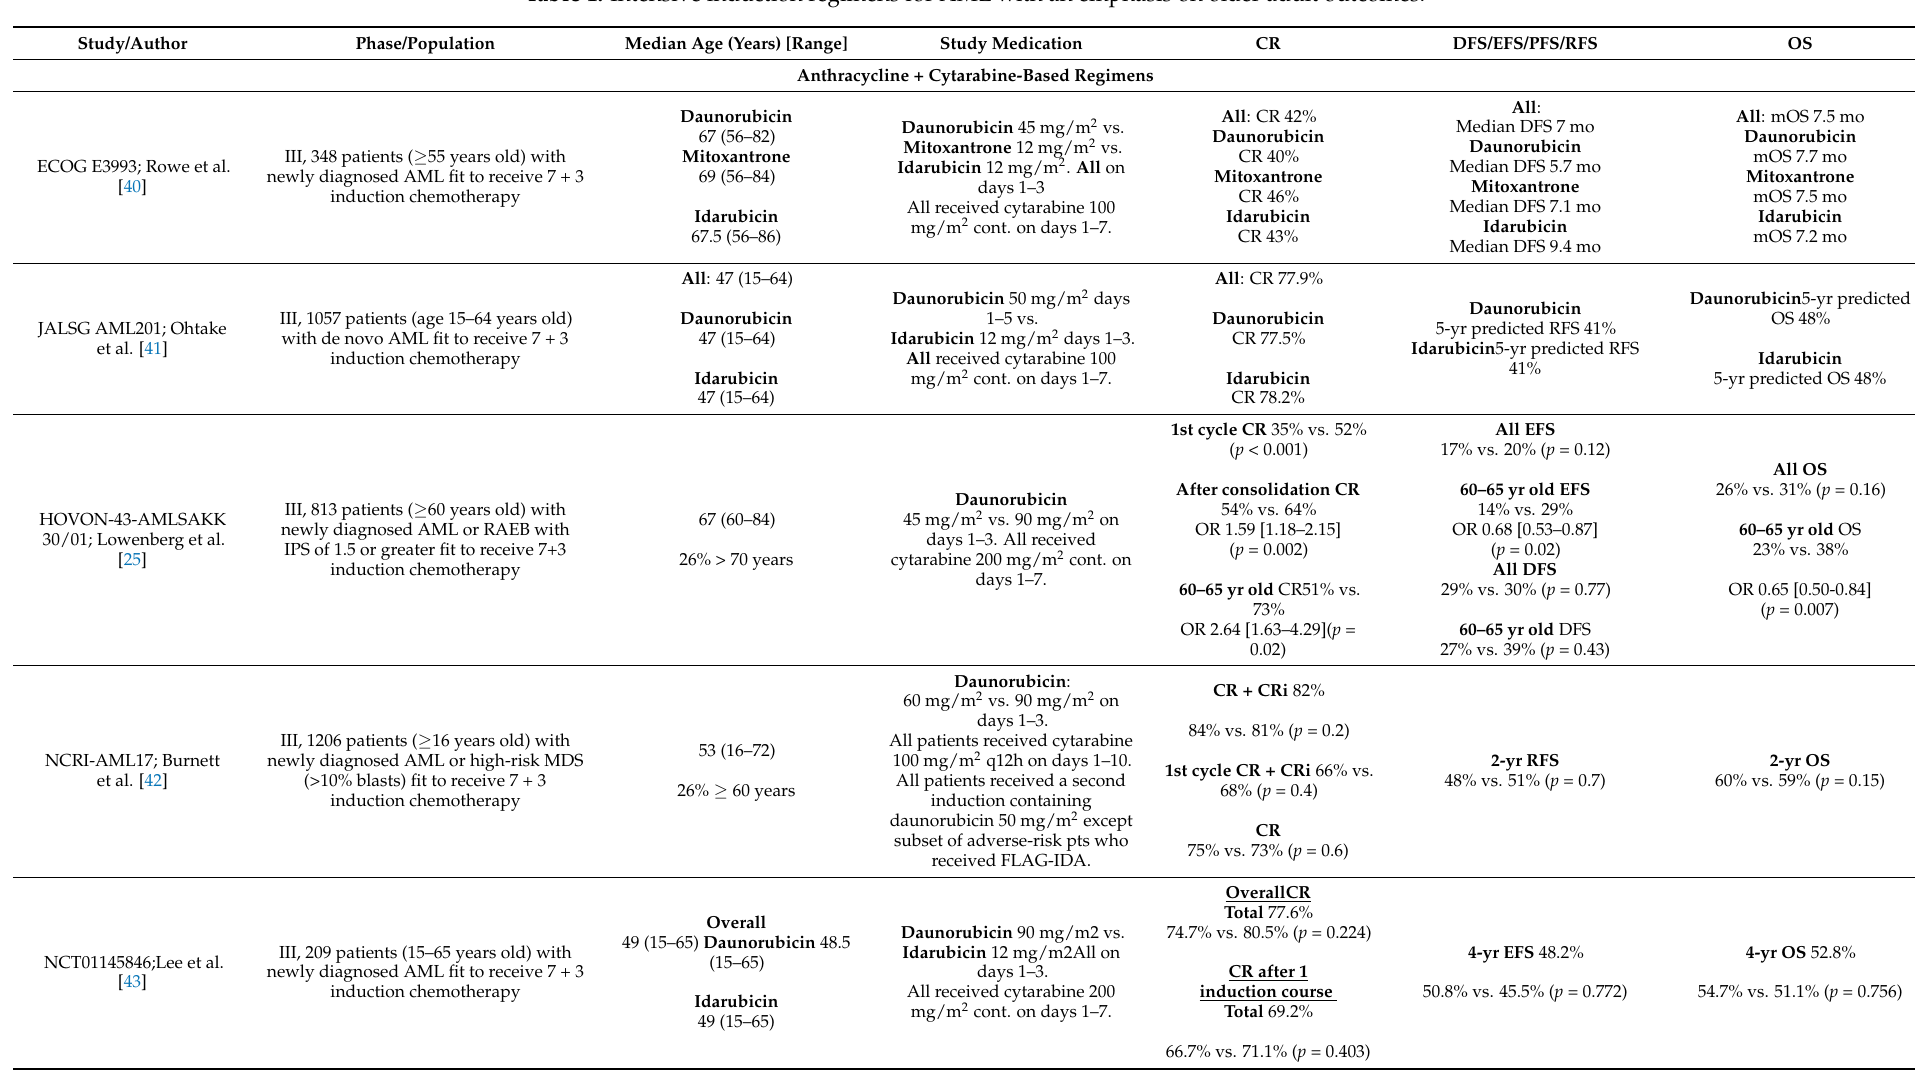
Table 1. Intensive induction regimens for AML with an emphasis on older adult